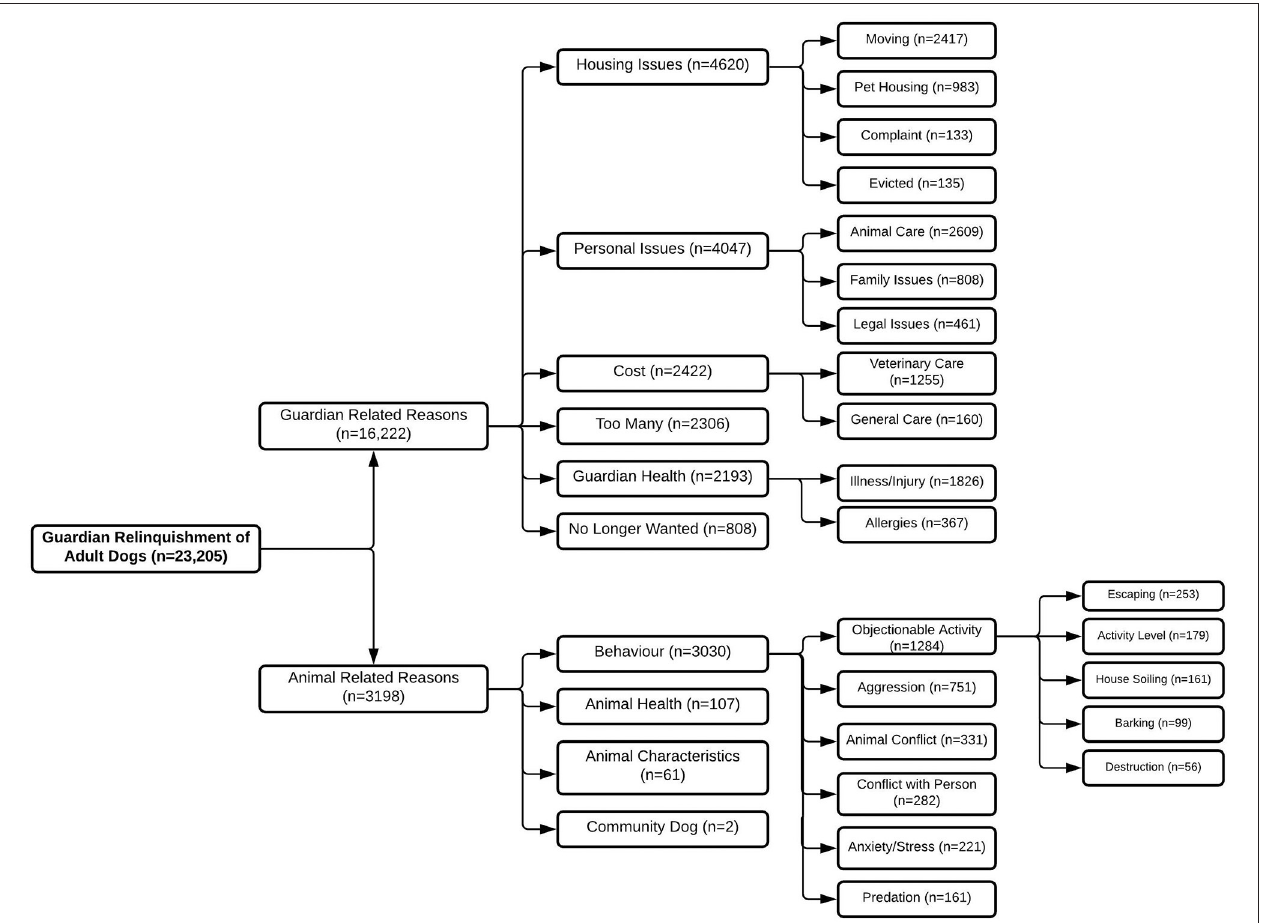
FIGURE 3 | The number of adult dogs relinquished to the BC SPCA between 2008 and 2019 ( n = 23,205). Relinquishment reasons include reasons relating to the guardian ( n = 16,222) and reasons relating to the animal ( n = 3,198). Where enough information was provided for further classification, the number of dogs relinquished for sub-reasons is